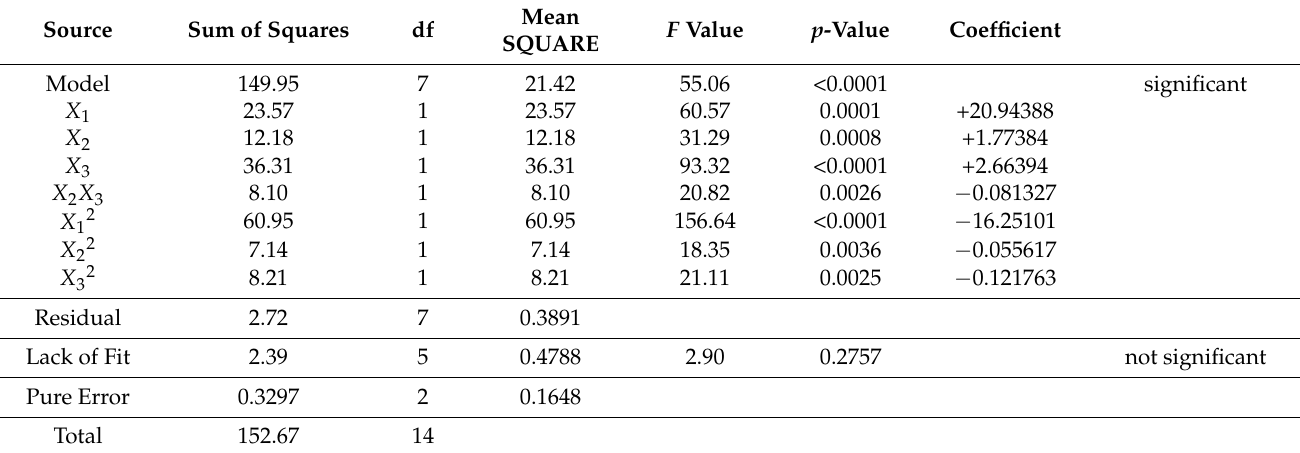
Table 1. ANOVA results for response: the total phenolic